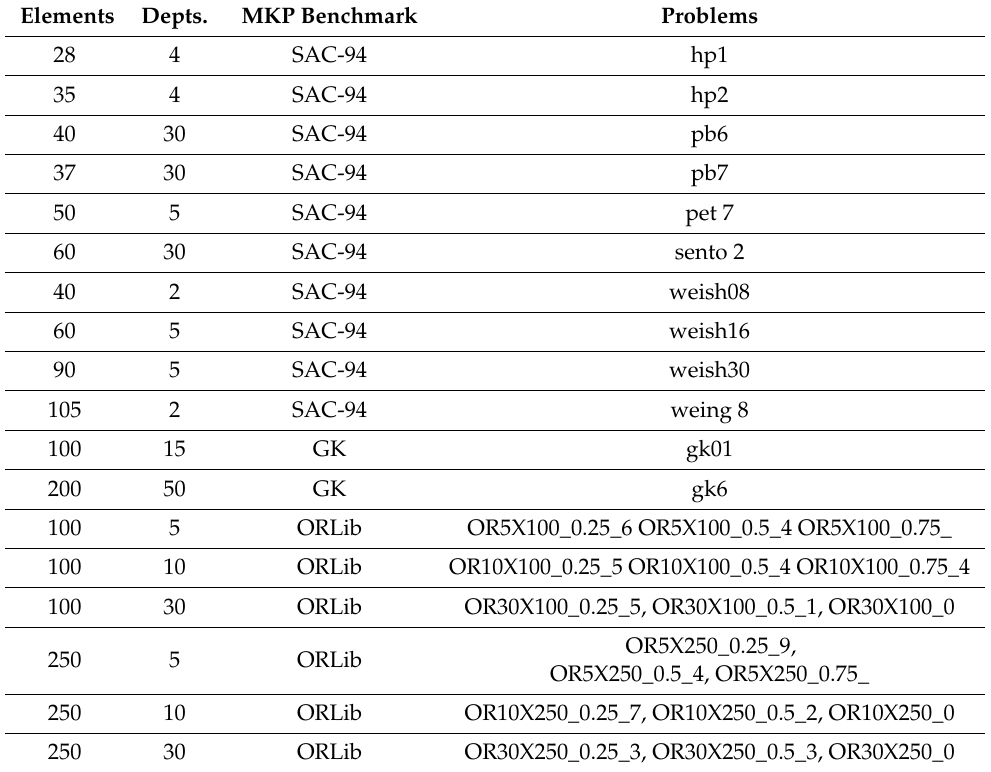
Table 8. MKP benchmark